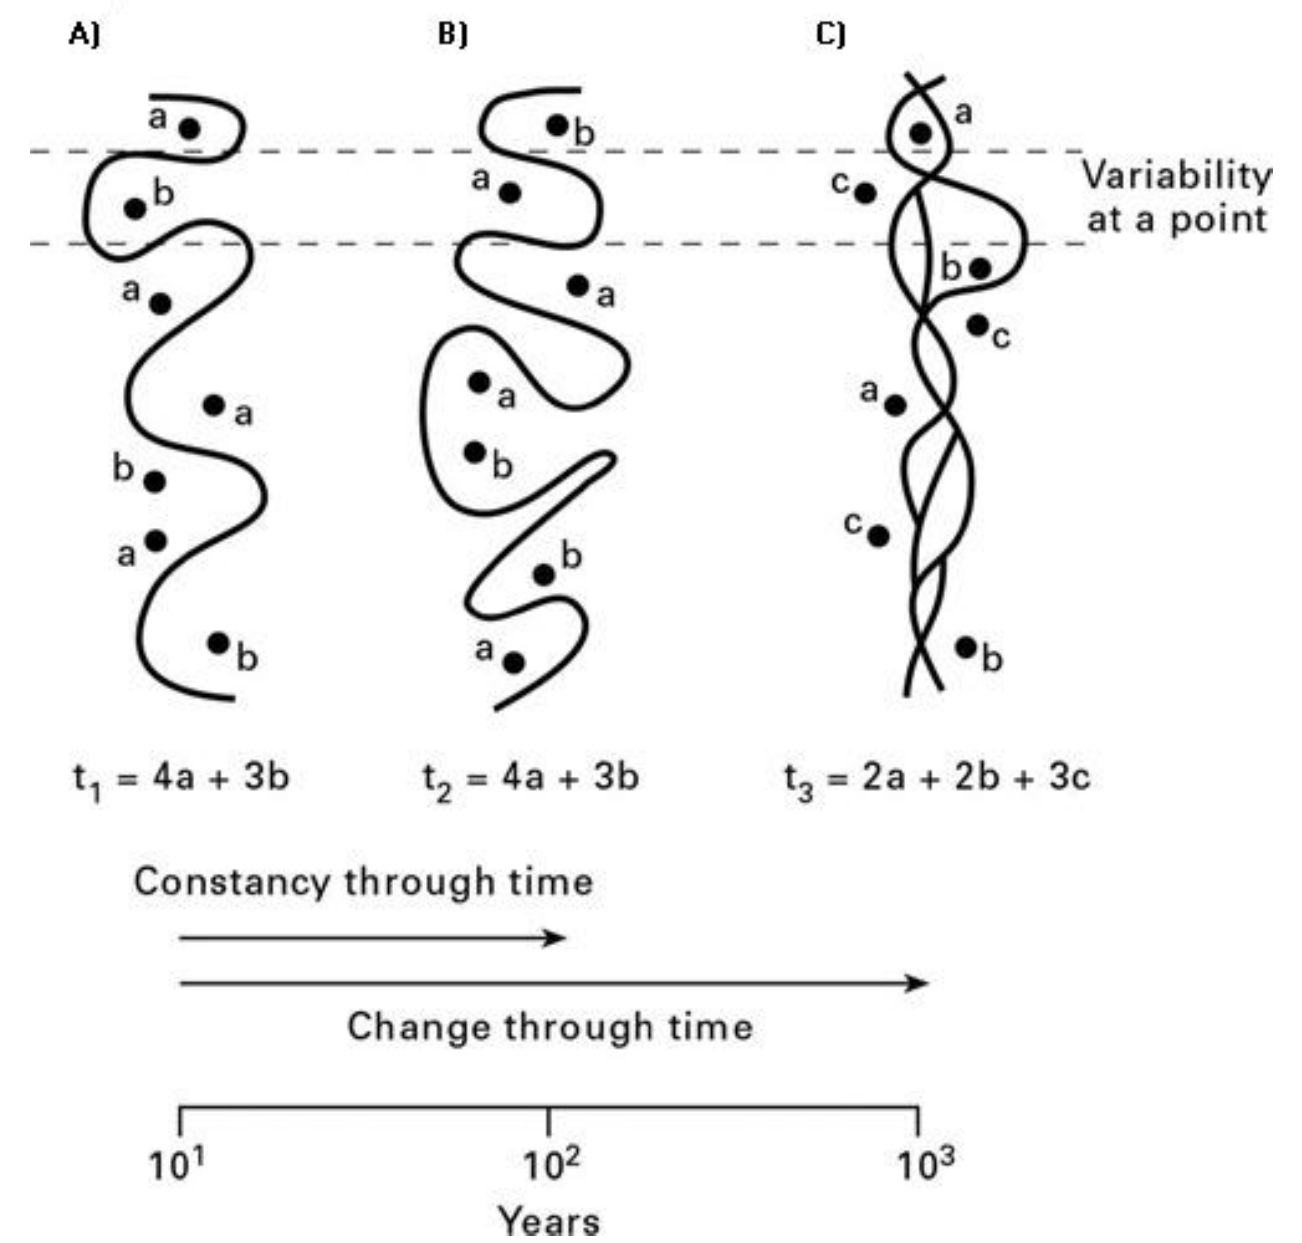
Fig. 3. At the scale of a whole floodplain, rapid change in the distribution of floodplain vegetation communities A and B can be observed between times t and t . However, the balance of the area occupied 1 2 by these three communities remains the same (Figs. 3A and 3B). Over a longer time period, there may be changes in catchment parameters that alter the geomorphological patterns and hydrological activity of the river. By time t , the meandering river has become braided, and a new vegetation community (C) has 3 arrived. The balance of floodplain vegetation communities has now changed (Fig.